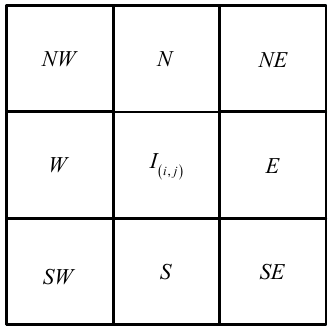
Figure 8. The four triples of current block.